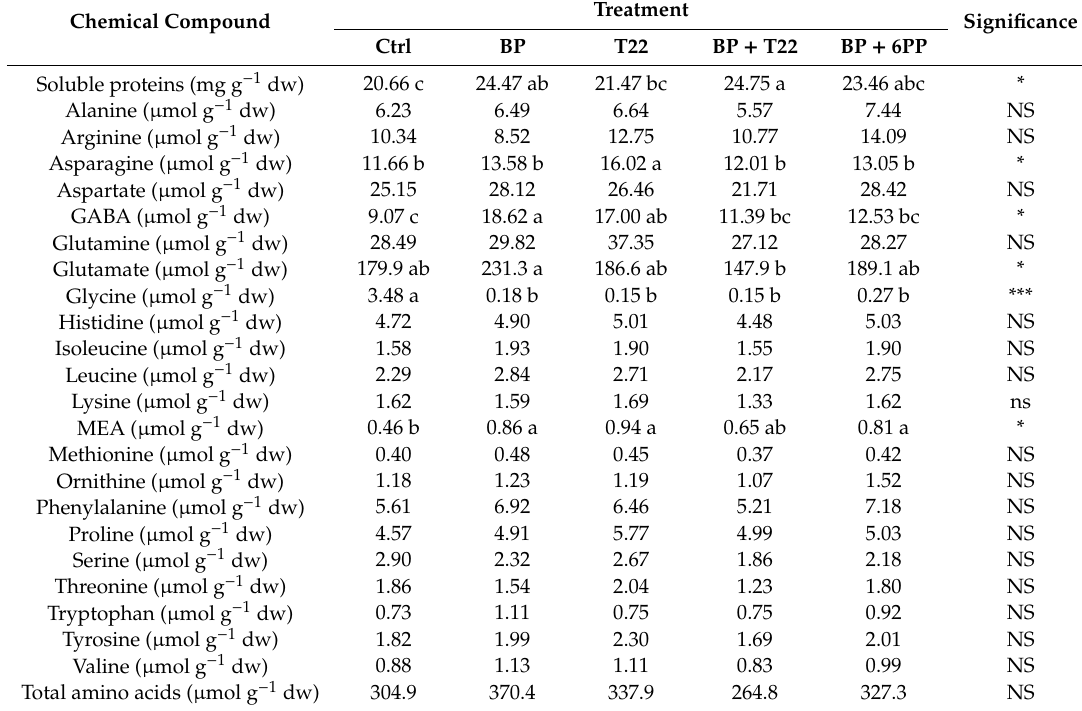
Table 3. E ff ects of Trichoderma harzianum strain T22 (T22) or biopolymer (BP) applications alone or in combinations (BP + T22 or BP + 6PP) on soluble proteins, free amino acid profile and total amino acid content of greenhouse tomato fruits. The control was not treated with biostimulants